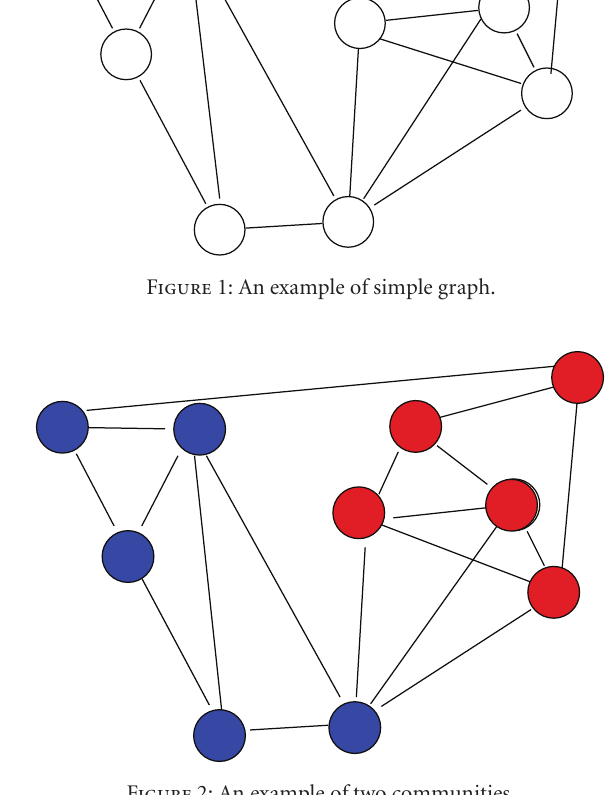
Figure 2: An example of two